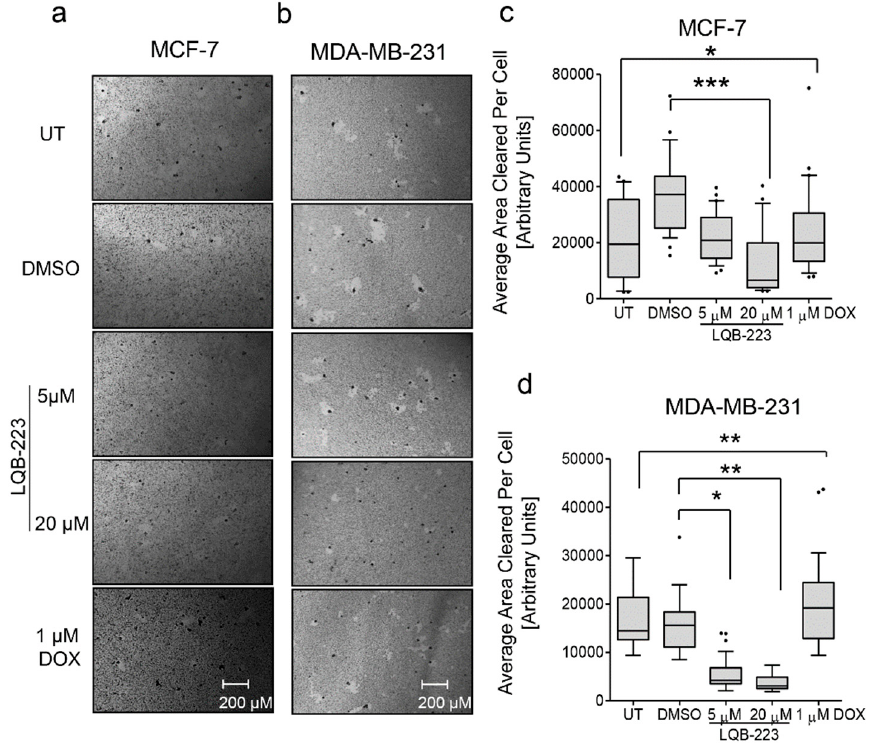
Figure 2. LQB-223 impairs motility of MCF-7 and MDA-MB-231 cells. ( a ) MCF-7 and ( b ) MDA-MB-231 cells were seeded onto 24-well plates coated with colloidal gold and treated with 5 or 20 µ M of LQB-223 or 1 µ M DOX for 24 h. The motility tracks were monitored under microscopy at 10 × magnification and analyzed using the ImageJ software. Average area cleared per cell is shown for ( c ) MCF-7 and ( d ) MDA-MB-231 from three independent experiments. Statistical significance was analyzed using the one-way ANOVA test (* p < 0.05; ** p < 0.01; *** p < 0.001). UT: Untreated cells; DMSO: Dimethyl sulfoxide; DOX: Doxorubicin.